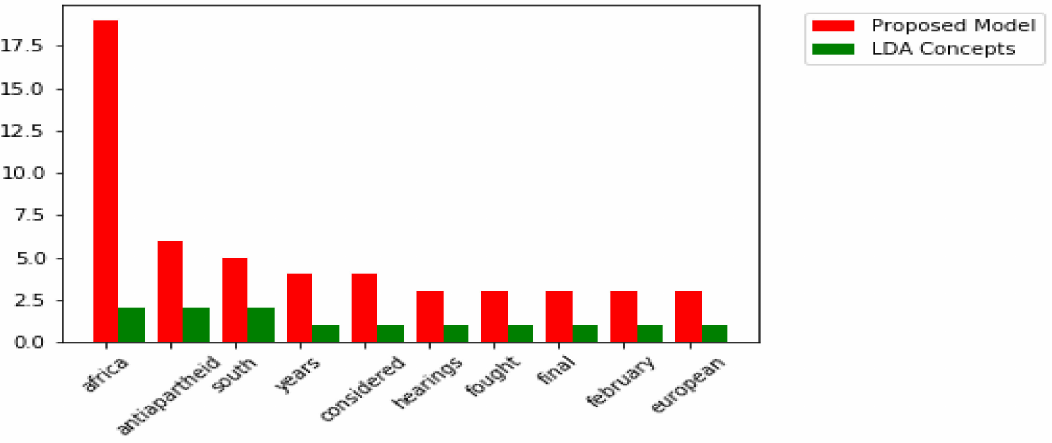
Figure 7. A comparison of the proposed model with the LDA